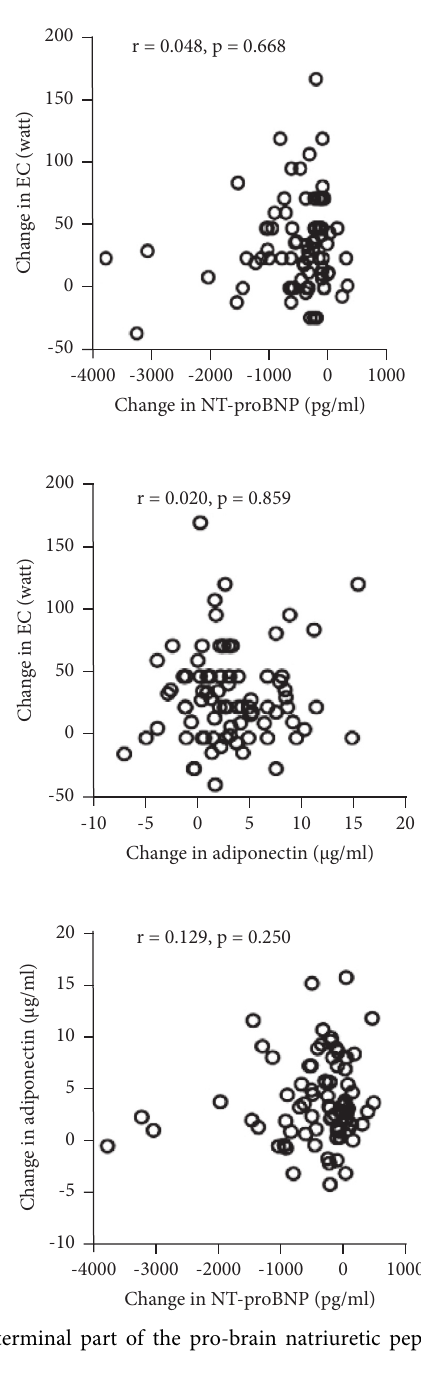
Figure 4: Relation between changes in N-terminal part of the pro-brain natriuretic peptide (NT-proBNP), adiponectin, and exercise capacity (EC) from baseline to 12